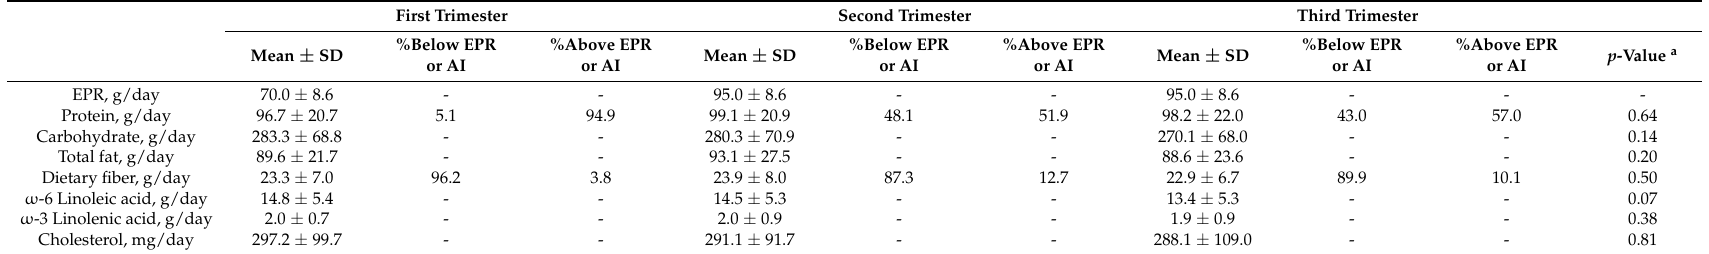
Table 3. Trimester-specific macronutrient intakes in comparison with dietary reference